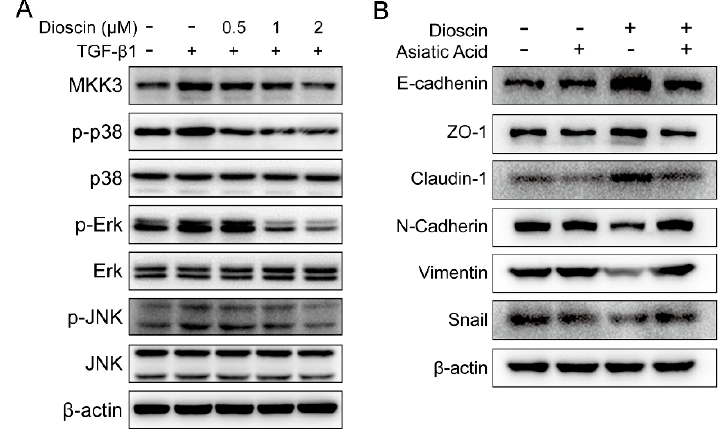
Figure 4. Dioscin treatment down-regulates activation of key kinases in the MAPK pathway. ( A ) The expression of the key kinases of MAPK pathway in HepG2 cells. ( B ) The expression of EMT markers in the TGF- β 1-induced HepG2 cells. Cells were treated with 5 ng / mL TGF- β 1 for 24 h and then with the addition of dioscin and / or 5 µ M of Asiatic acid continuously cultured for additional 24 h.